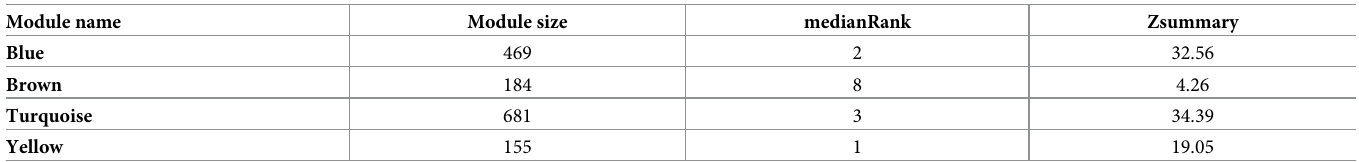
Table 1. Details of conservation analysis of defined modules at different developmental phases with permutation=200. Module